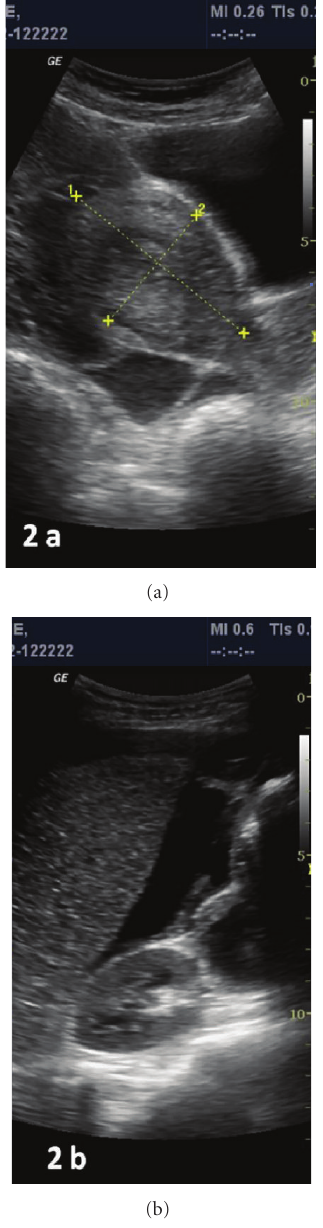
Figure 2: (a) Rudimentary horn with rupture of posterior wall and pelvic collection; (b) moderate free fluid in Morrison’s